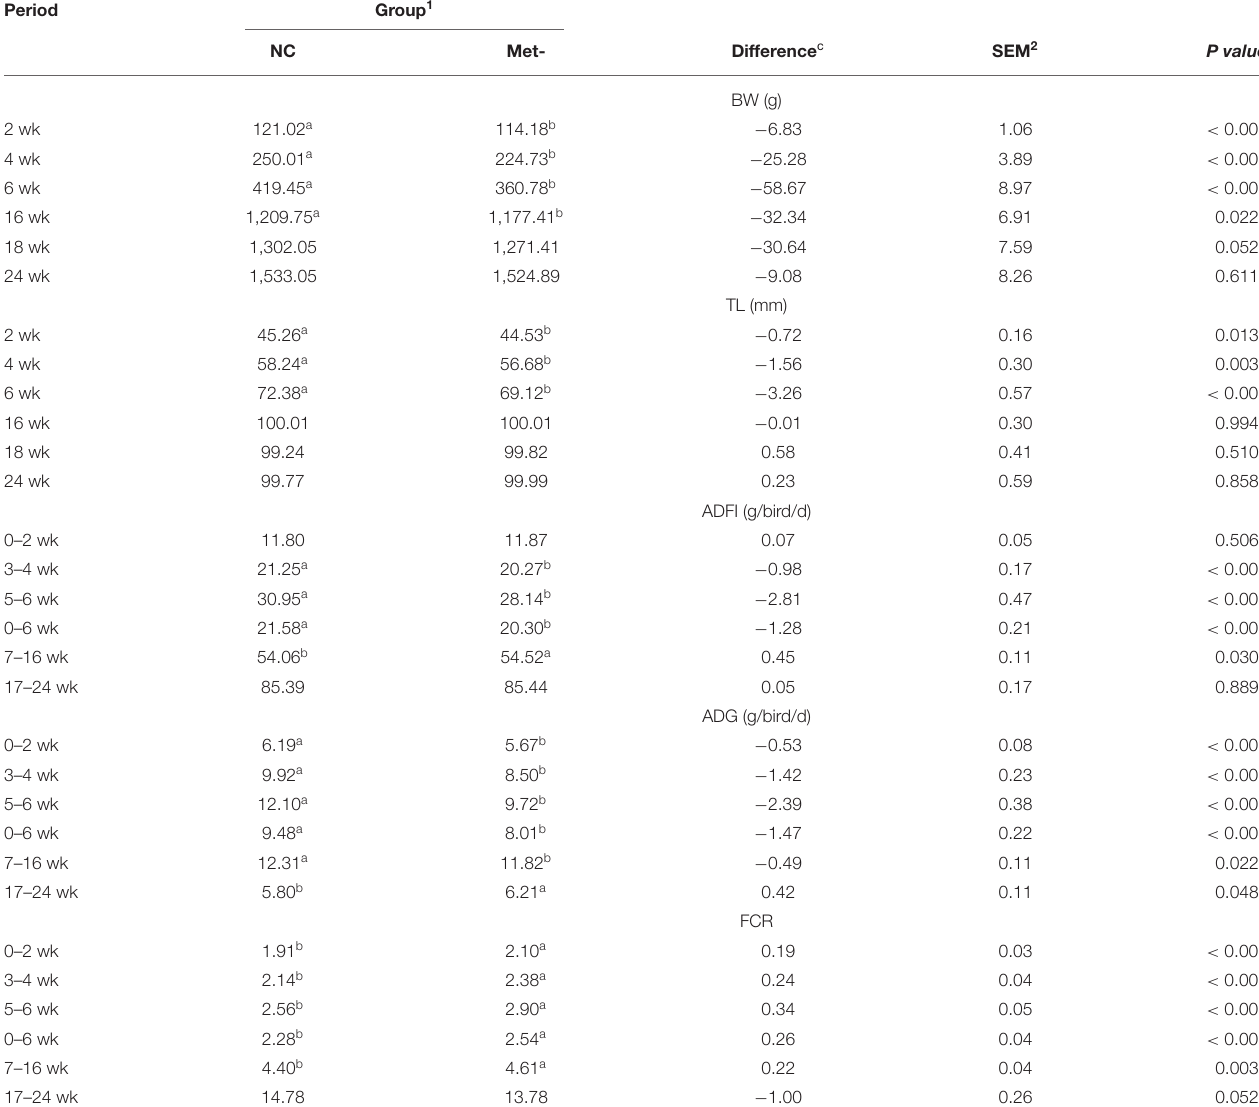
TABLE 2 | Effects of Met deficiency in rearing period diets on growth performance of egg-laying chicks.